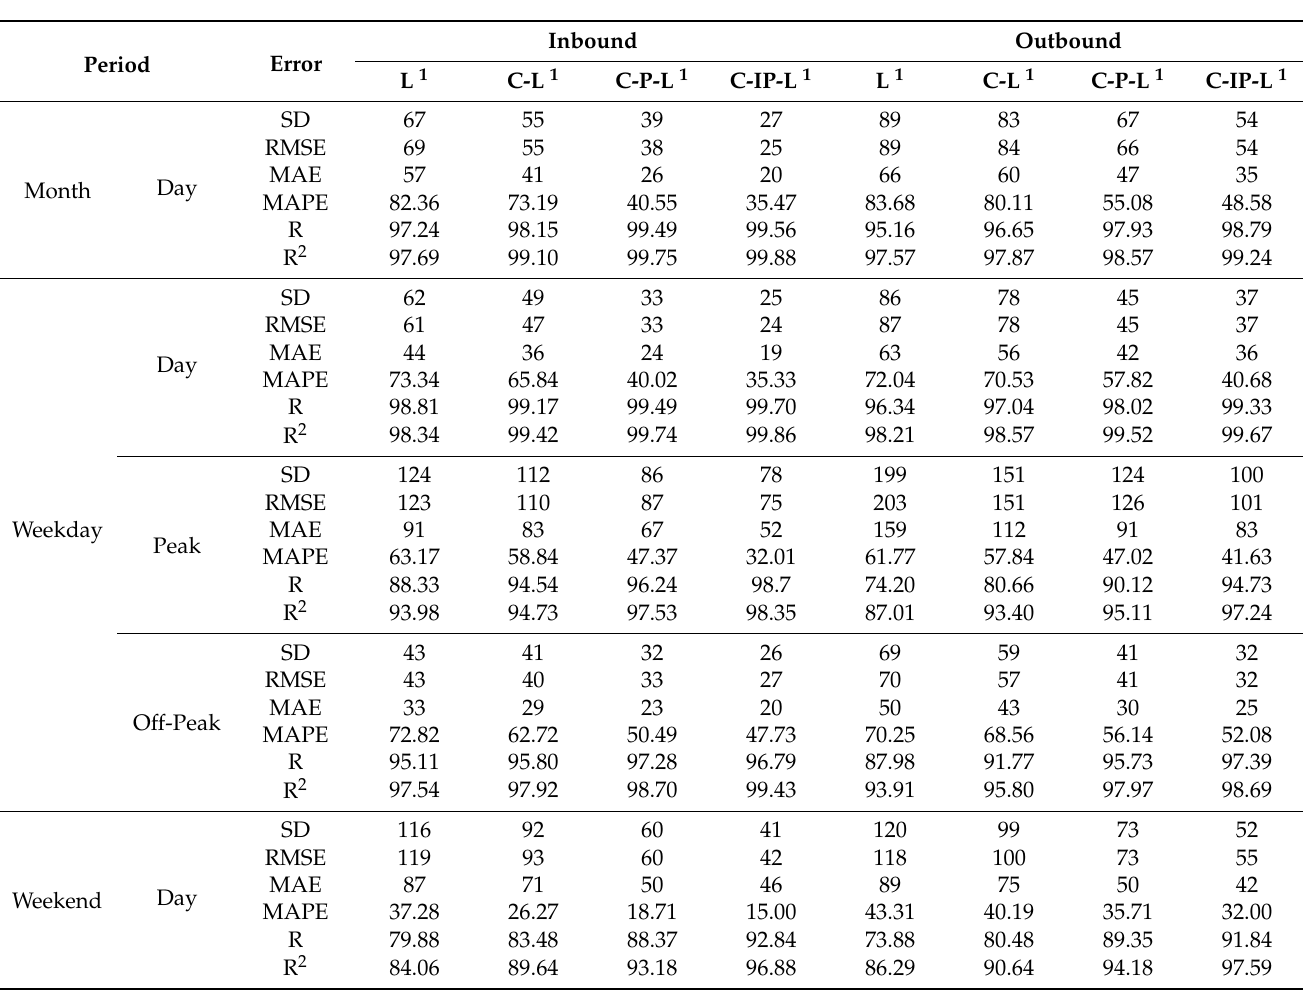
Table 3. Comparison of prediction